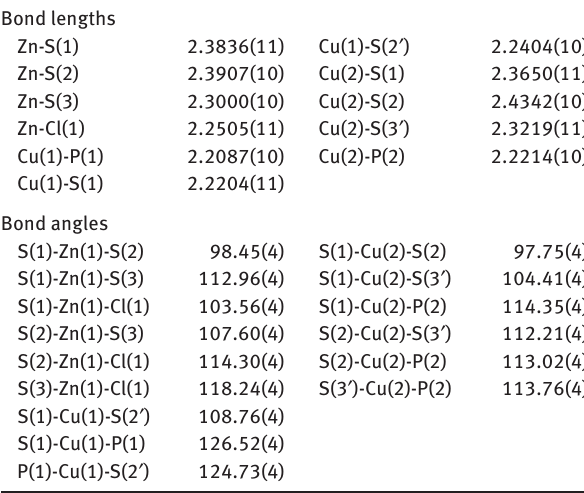
Table 1: Selected bond distances (Å) and angles ( o ) for 1 . Bond